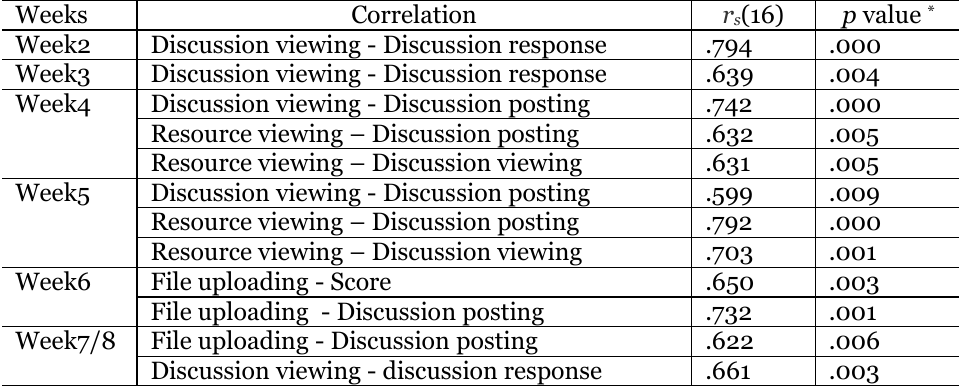
Weeks Correlation r s (16) p value * Week2 Discussion viewing - Discussion